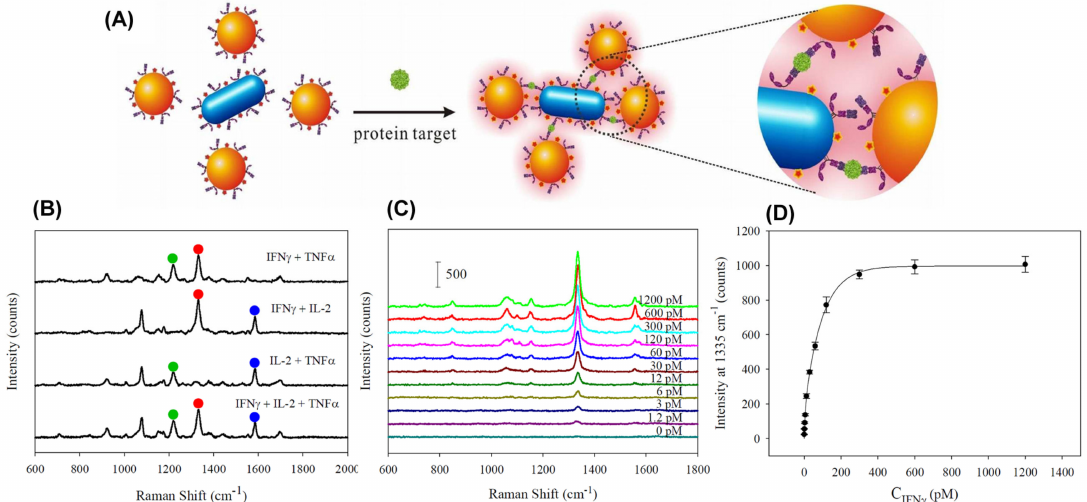
Figure 5. ( A ) Illustration of single-step SERS immunoassay based on plasmonic coupling enhancement via sandwich assembly; ( B ) SERS spectra obtained in response to different combinations of proteins targets; ( C ) SERS response for immunoassay of recombinant human interferon gamma (INF γ ) protein with varying concentration; ( D ) The peak intensity at 1335 cm − 1 as a function of INF γ concentration. (Reprinted with permission from Reference [73] Copyright (2013) published by American Chemical